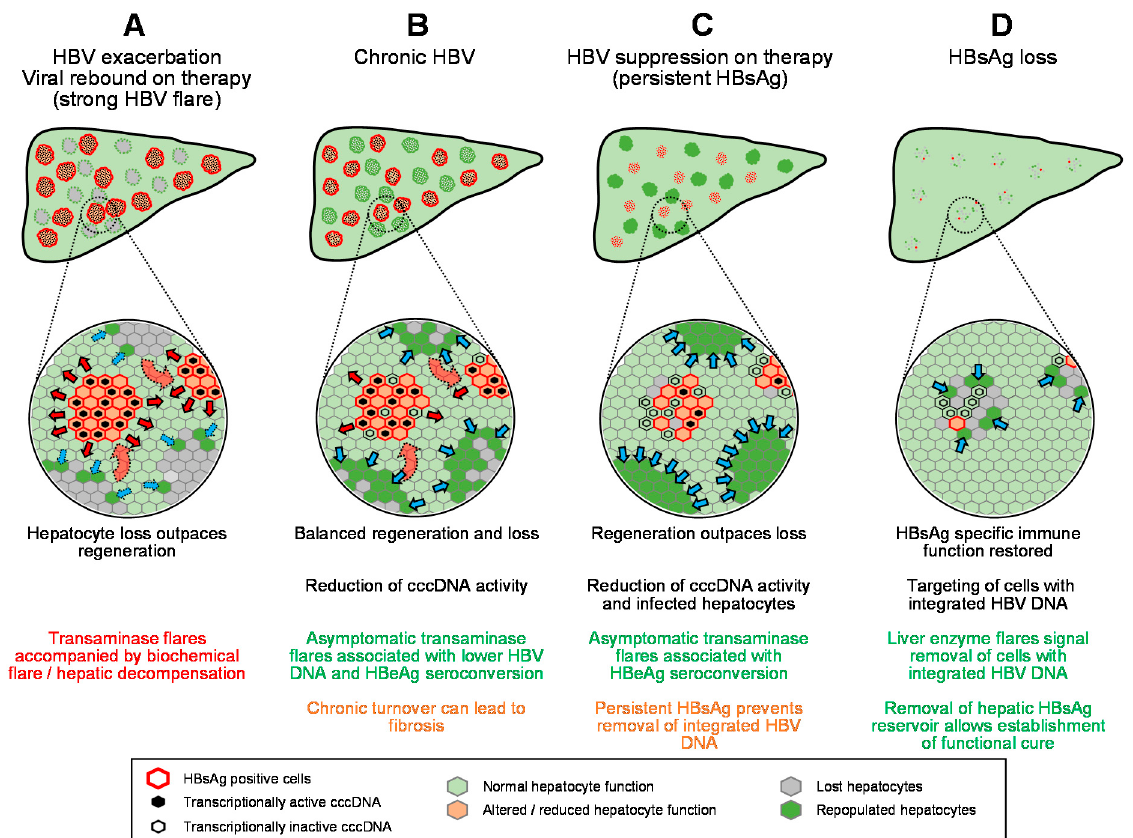
Figure 3. Model for the equilibrium between loss and regeneration of the hepatic reservoir during chronic HBV infection. Red arrows indicate expansion of HBV infection, blue arrows indicate regeneration of normal hepatocytes.